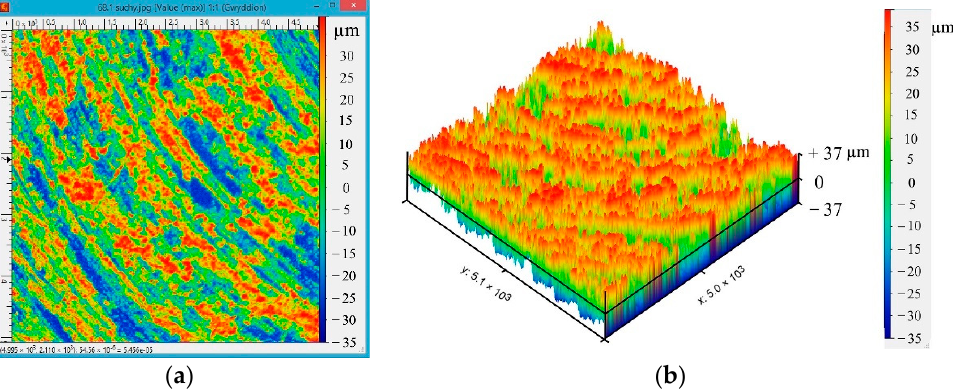
Figure 7. Dry cutting surfaces of 38KHN3MFA steel samples: 2D visualization ( a ) and 3D visualiza- tion ( b ) in the Gwyddion computer package.